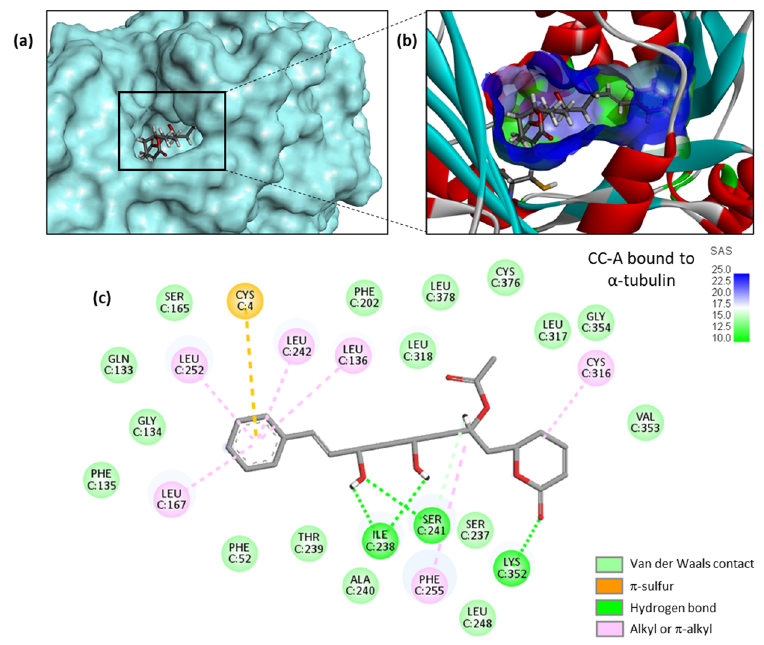
Figure 3. Molecular model of cryptoconcatone A (CC-A) bound to α -tubulin. ( a ) CC-A fits into a cavity of the protein. ( b ) A close-up view of CC-A inserted into the binding cavity, with the solvent- accessible surface (SAS) surrounding the drug binding zone (color code indicated). A ribbon model of α -tubulin is shown, with α -helices (in red) and β -sheets (in cyan). ( c ) Binding map contacts for CC-A bound to α -tubulin (color code indicated). Table 1. Calculated potential energy of interaction ( Δ E) and free energy of hydration ( Δ G) for the interaction of the indicated natural products with tubulin.